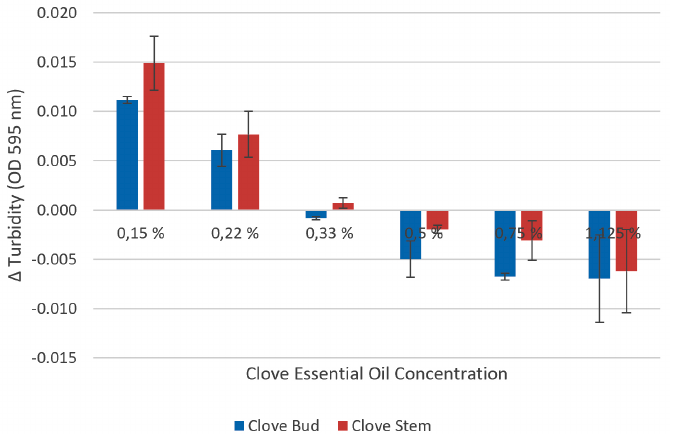
Fig. 1. MIC assay of clove essential oil microemulsion. Clove bud essential oil’s MIC was 0.33%, while clove stem essential oil’s MIC was